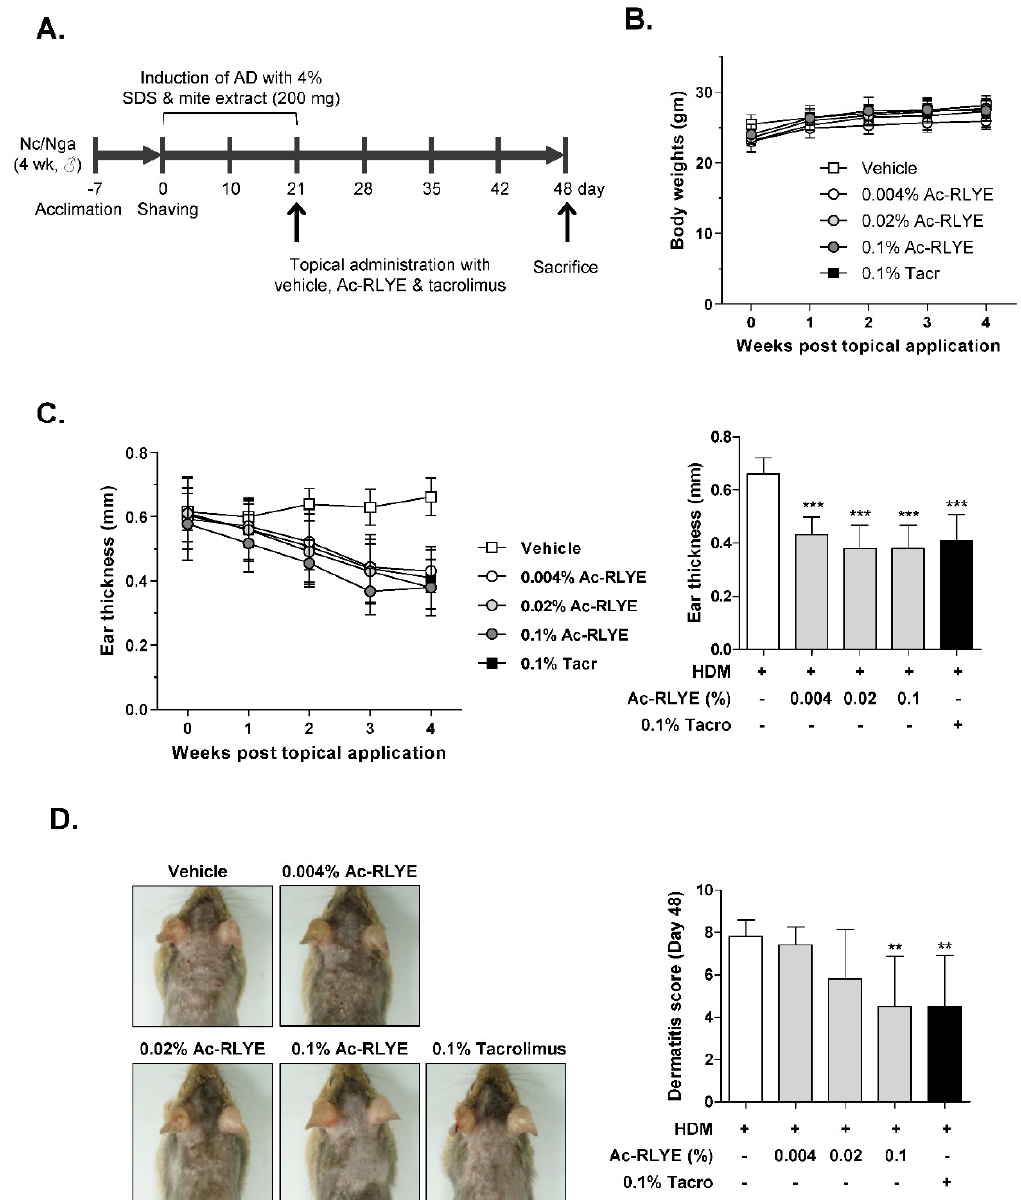
Figure 2. Ac-RLYE alleviates AD-like skin lesions in NC/Nga mice. ( A ) A schematic diagram showing the induction and treatment of AD. ( B ) Body weights were measured for 4 weeks post topical application of Ac-RLYE or tacrolimus (Days 20–48). ( C ) Ear thickness was measured weekly for 4 weeks after AD induction ( left ) and on Day 48 ( right ) ( n =10). ( D ) Representative pictures of mouse on Day 48. Dermatitis scores (gross examination) on Day 48 were defined as the sum of scores for four symptoms: erythema (hemorrhage), edema, excoriation (erosion), and scaling (dryness). Data are presented as mean ± SD values for each group ( n =10). ** p < 0.01, *** p < 0.001 in comparison to vehicle-treated